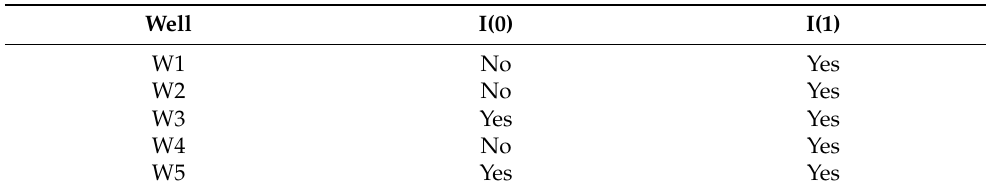
Table 1. Augmented Dickey–Fuller results for